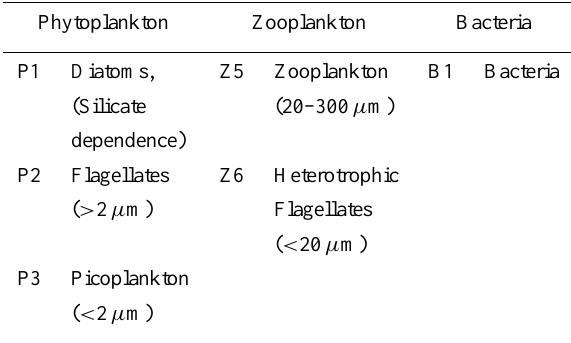
Fig. 1. Diagram showing the trophic links in ERSEM.